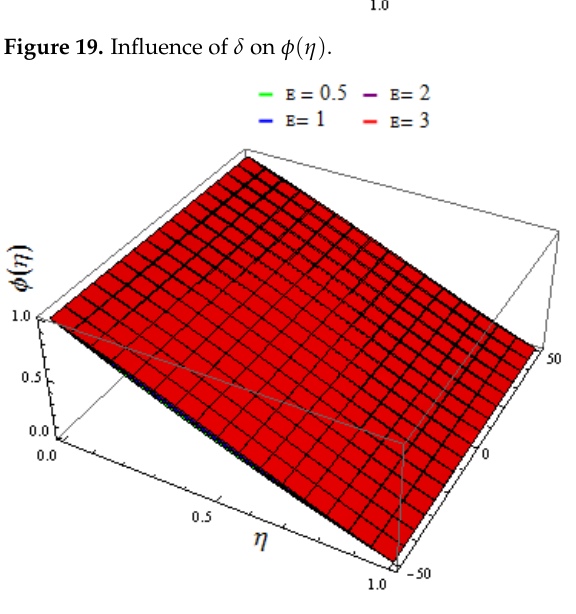
Mathematics 2023 , 11 , x FOR PEER REVIEW Figure 19. Influence of 𝛿 on 𝜙(𝜂) . Figure 19. Influence of δ on φ ( η ) .